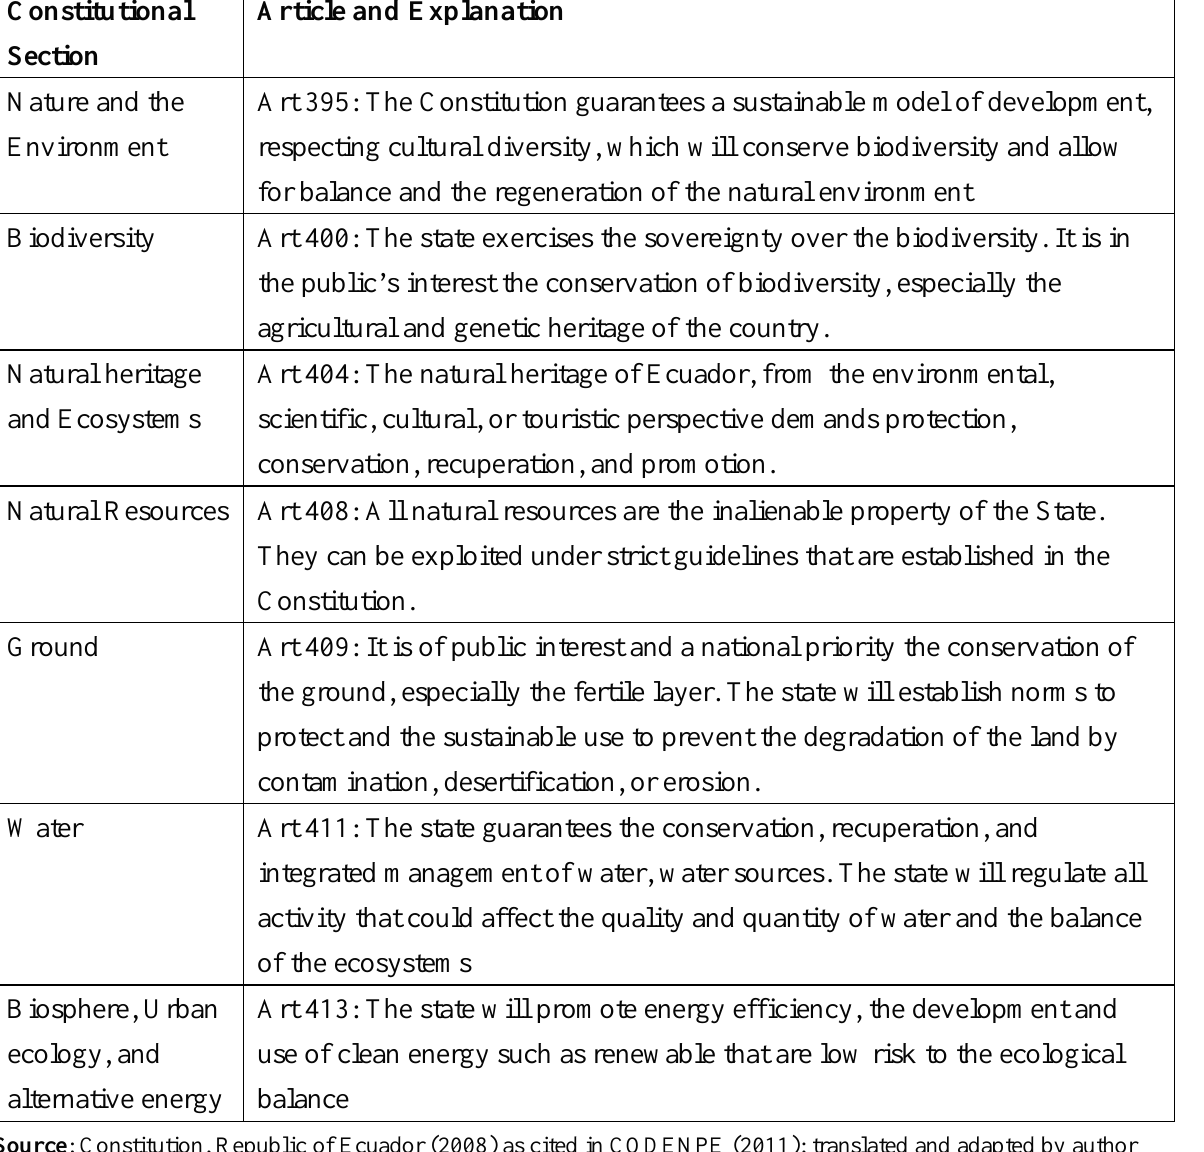
Table 2. Buen Vivir Regimen, Chapter 2 “Biodiversity and Natural Resources” in the 2008